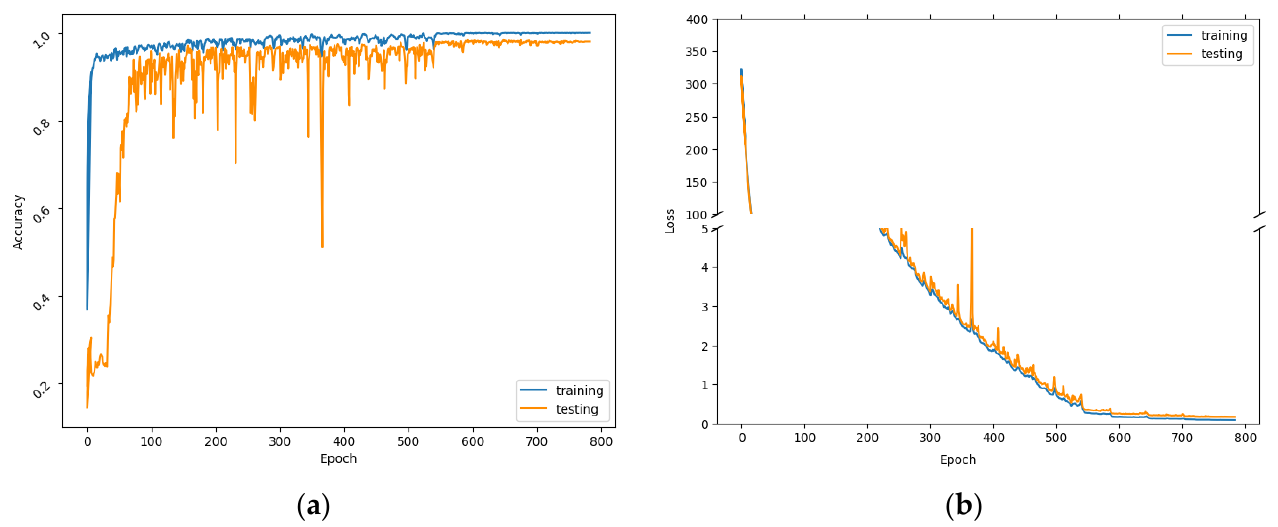
Sensors 2023 , 22 , x FOR PEER REVIEW